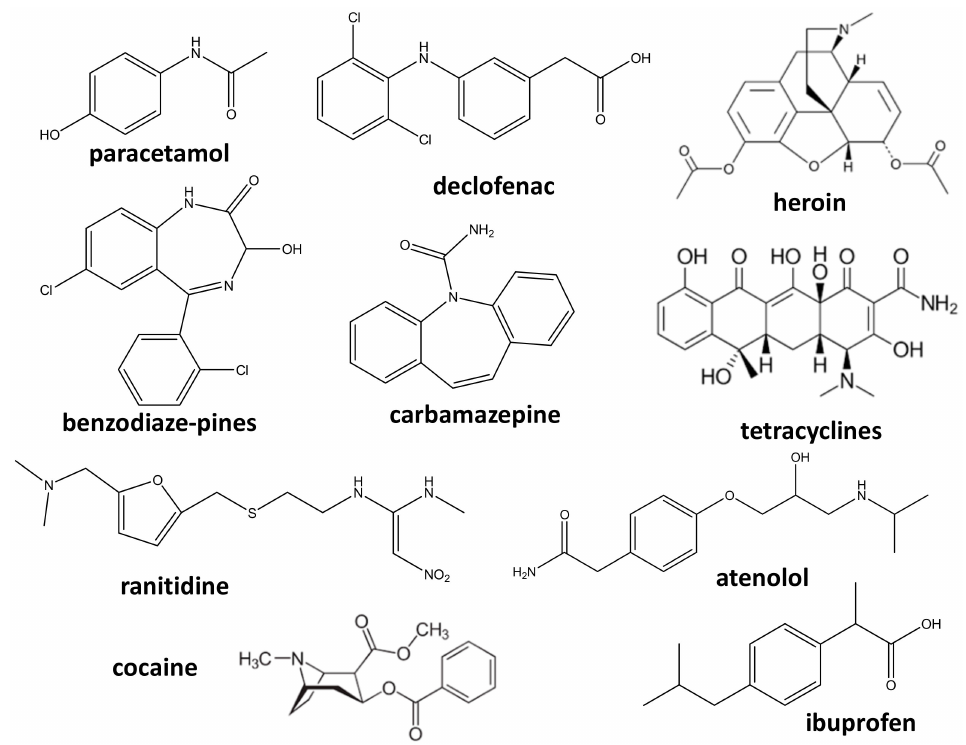
Figure 1. Examples of the pharmaceuticals considered as emerging contaminants